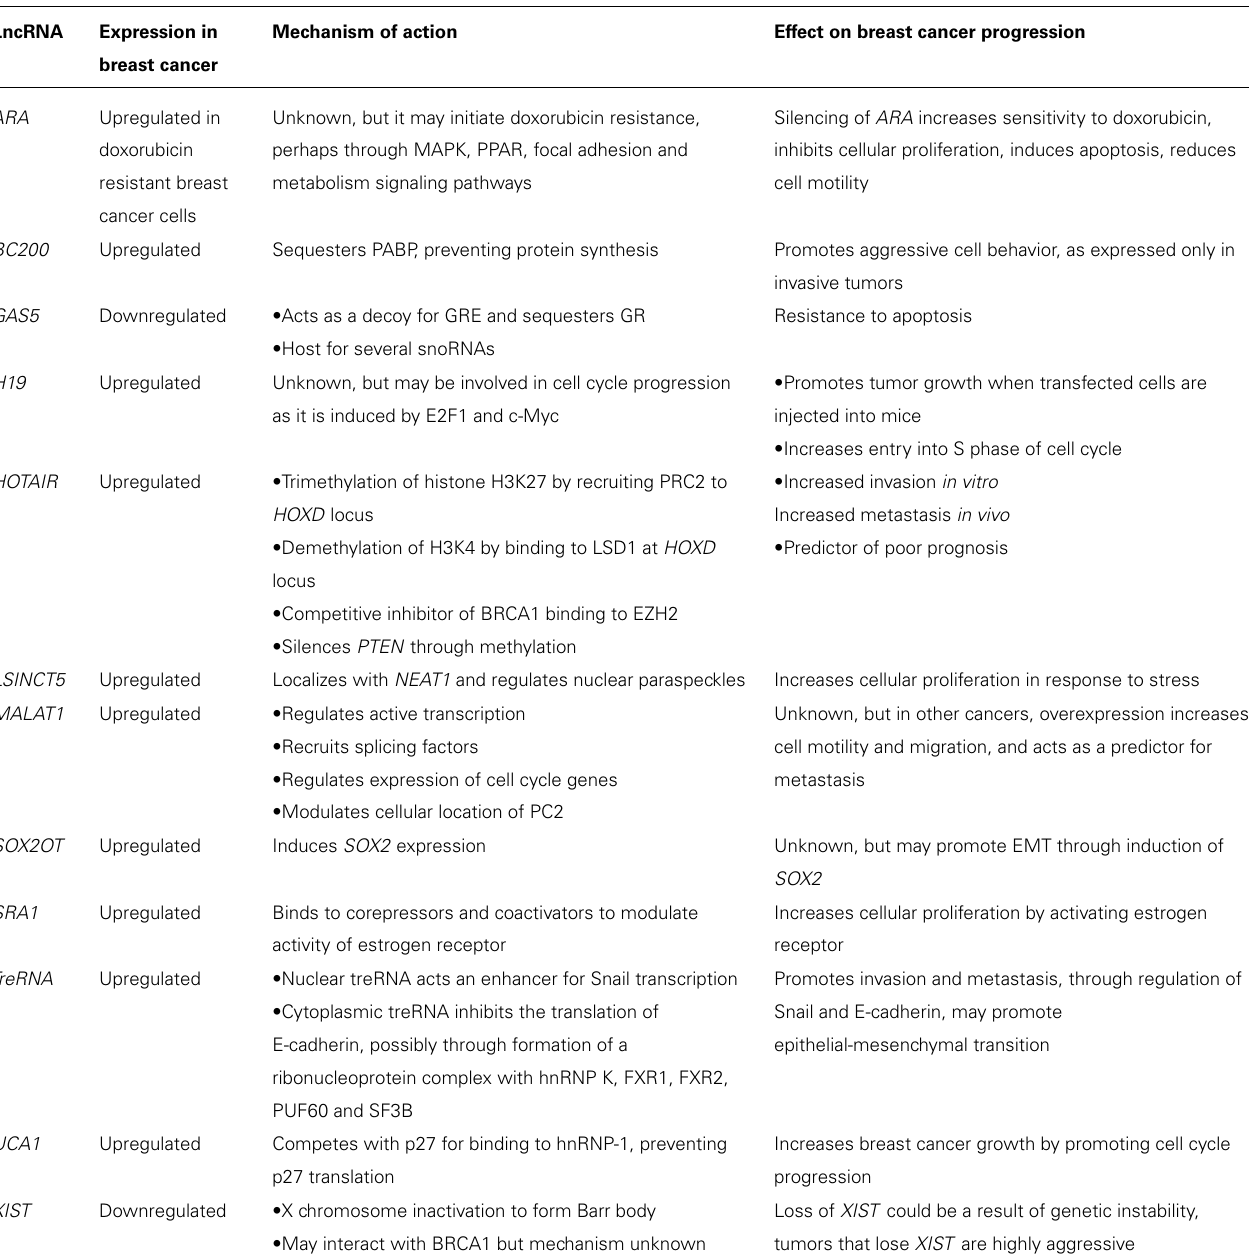
Table 1 | List of lncRNAs involved in breast cancer progression with their proposed functions.